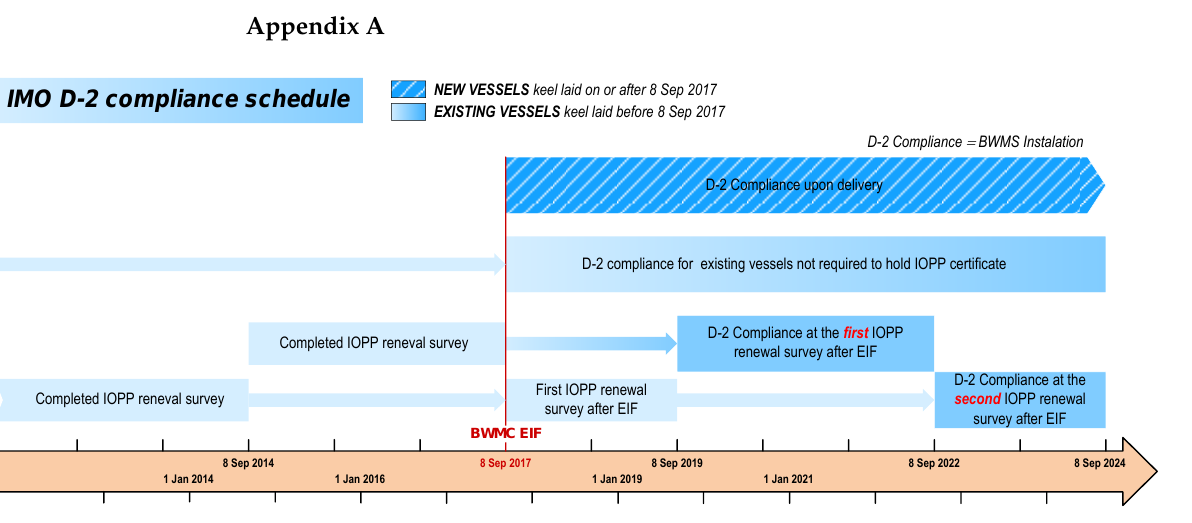
Figure A1. BWMC Regulation D-2 compliance schedule. Source: adopted from [34].